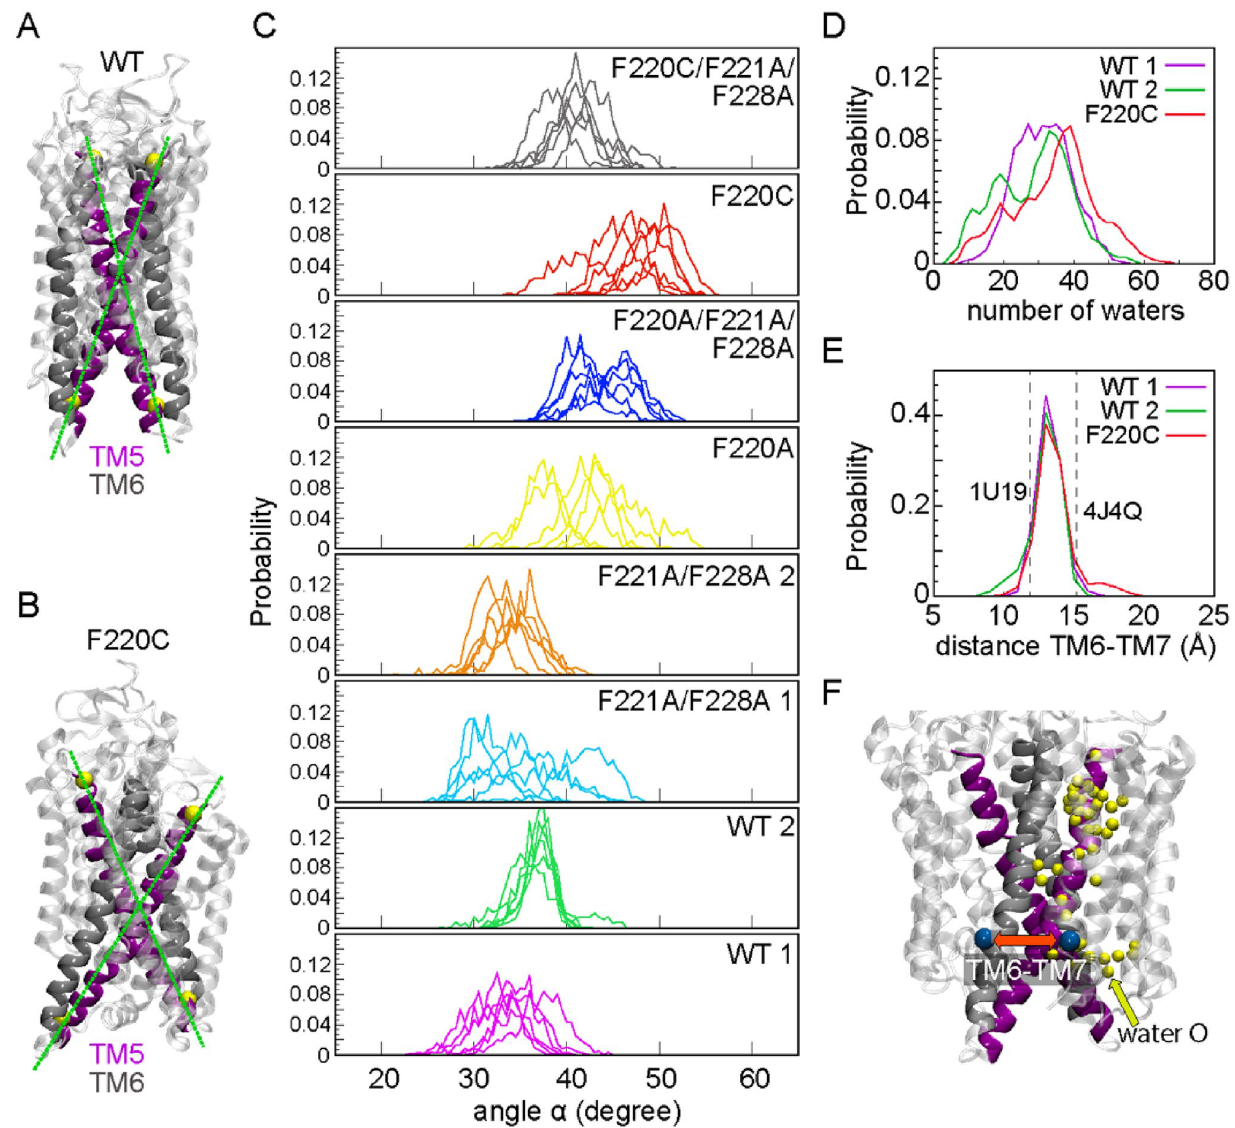
Figure 7. ( A,B ) Snapshots from all-atom MD simulations comparing mutual orientations of the two monomers in dimers of the WT (A) and F220C (B) constructs. TM5 and TM6 helices are shown in purple and silver, respectively. The rest of the protein is in transparent white color. Solid lines connect C α atoms of residues 200 and 234 (yellow spheres) used to define the orientation of TM5 helix in each monomer (see text). ( C ) Probability distributions of the splay angle α between the two TM5 helices in the dimers of various constructs described in the text. The color coding of the systems follows the same pattern as in Fig. 6. The results for each replicate are shown separately (i.e. 6 plots per constructs). ( D ) Histogram of water counts in the interior of each monomer of the WT (Modes 1 and 2) and F220C dimers. For this analysis, in each trajectory, for a given dimer, water oxygen atoms within 7 Å of the sidechains of residues 264, 268, 272, 127, and 131 were counted in each monomer. The data was then combined for two monomers and for all the trajectories per construct (i.e. WT 1, WT 2, and F220C) and binned using a bin size of 2. ( E ) Histogram of C α -C α distance between residues 252 and 308 on each monomer of the WT (Modes 1 and 2) and F220C dimers. To construct the histogram, the data for each monomer and for all trajectories of each construct was combined and binned using a bin size of 1 Å. ( F ) A snapshot of the F220C dimer as in panel B, highlighting water penetration (yellow spheres show water oxygens in the protein interior) and the distance between TM6-TM7 distance reported in panel E (blue spheres are C α atoms of residues 252 and